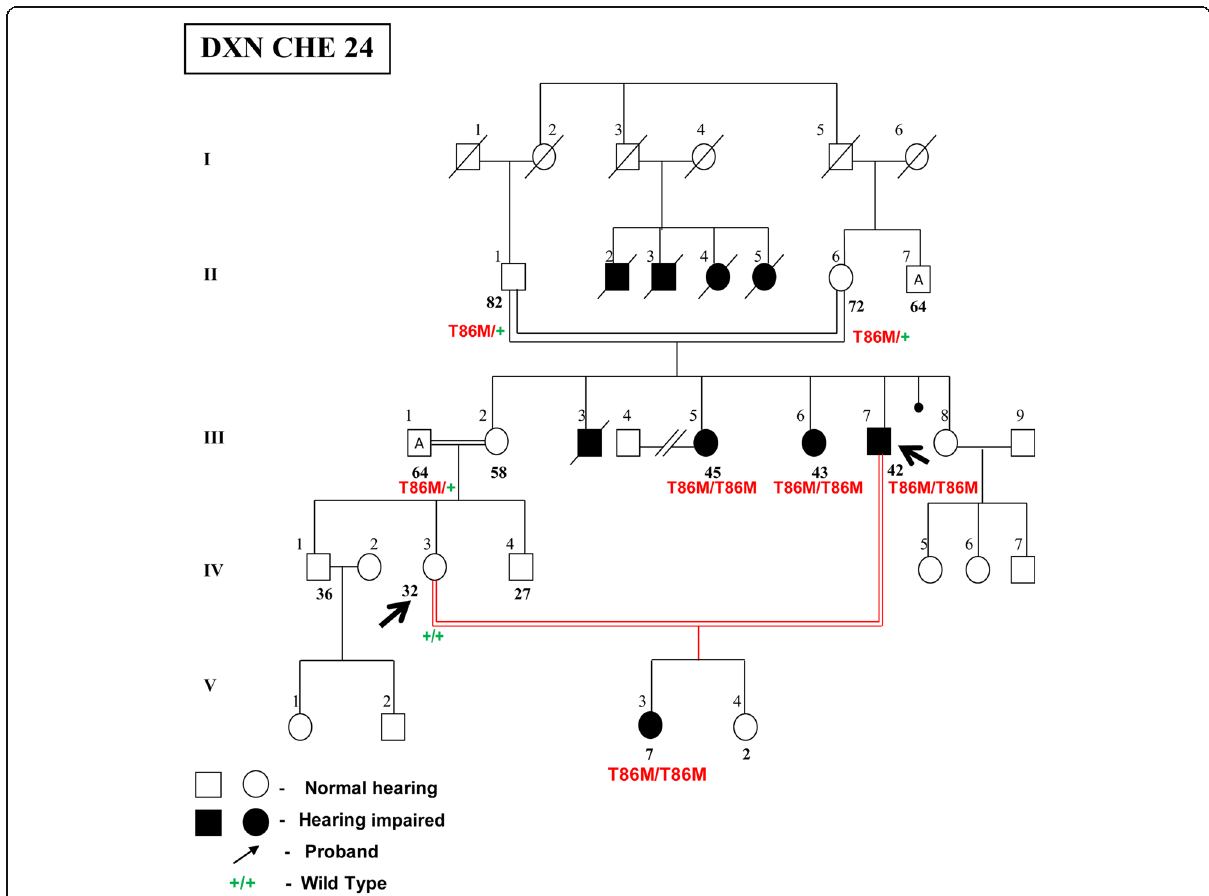
Fig. 9 Pedigree of DXN CHE 24 family showing p.T86 M, a rare GJB2 mutation in three consecutive generations owing to